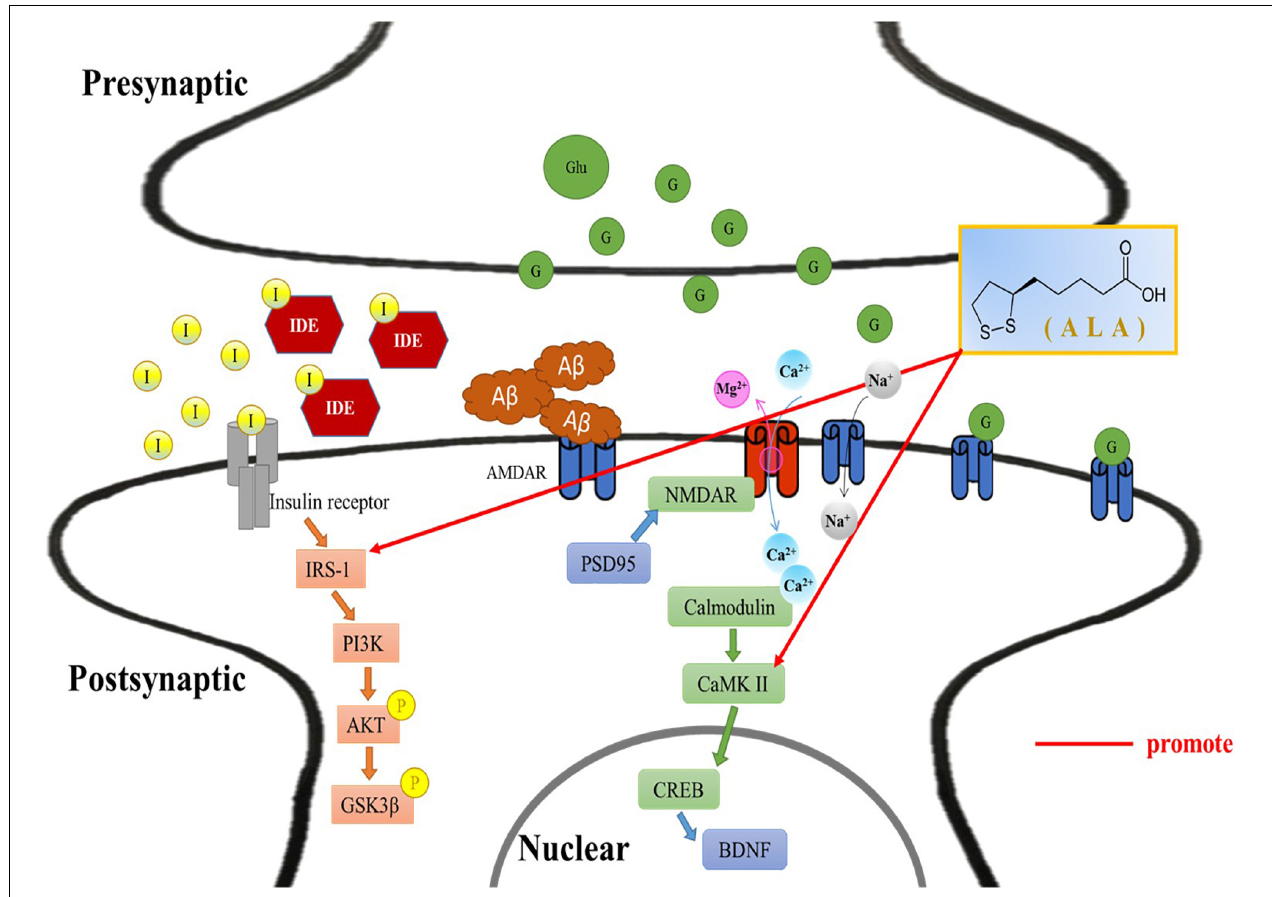
FIGURE 6 | Alleviative mechanism of α -lipoic acid (ALA) in the hippocampus and cortex of T2DM rats induced by HFD/STZ. Postulated mechanism through which ALA alleviates insulin receptor substrate-1 and calmodulin-dependent protein kinase II in the hippocampus and cortex of high-fat diet and streptozotocin-induced type 2 diabetic rats. I, insulin; IDE, insulin-degrading enzyme; IRS-1, insulin receptor substrate 1; PI3K, phosphoinositide 3-kinase; Akt/PKB, protein kinase B; P, phosphorylation; GSK-3 β , glycogen synthase kinase 3 β ; A β , β -amyloid; NMDAR, N -methyl- D -aspartate receptor; PSD-95, postsynaptic density protein 95; CaMKII, Ca 2 + /calmodulin-dependent protein kinase II; CREB, cyclic AMP response element-binding protein; BDNF, brain derived neurotrophic factor; Glu/G, glucose; ALA, α -lipoic